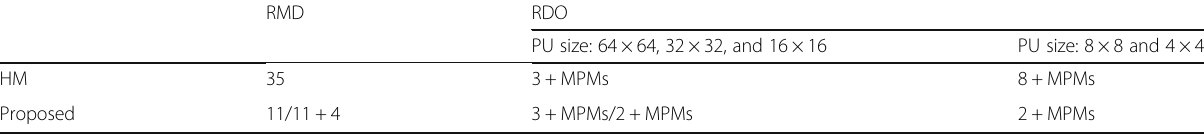
Table 3 The difference of modes will be tested in RMD and RDO process in HM and proposed